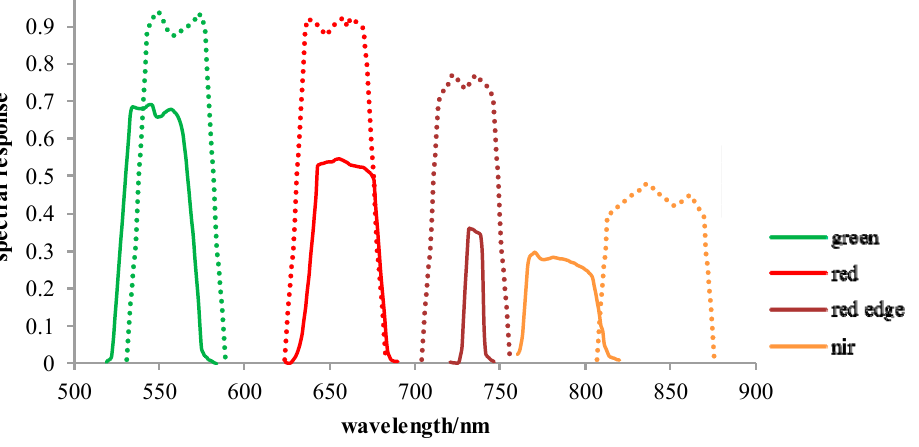
Figure 2. UAV platforms and multispectral sensors (Sequoia and P4M). The Sequoia sensor is carried on the EM6-800 hexarotor UAV (left), and the P4M uses its own aircraft (right).